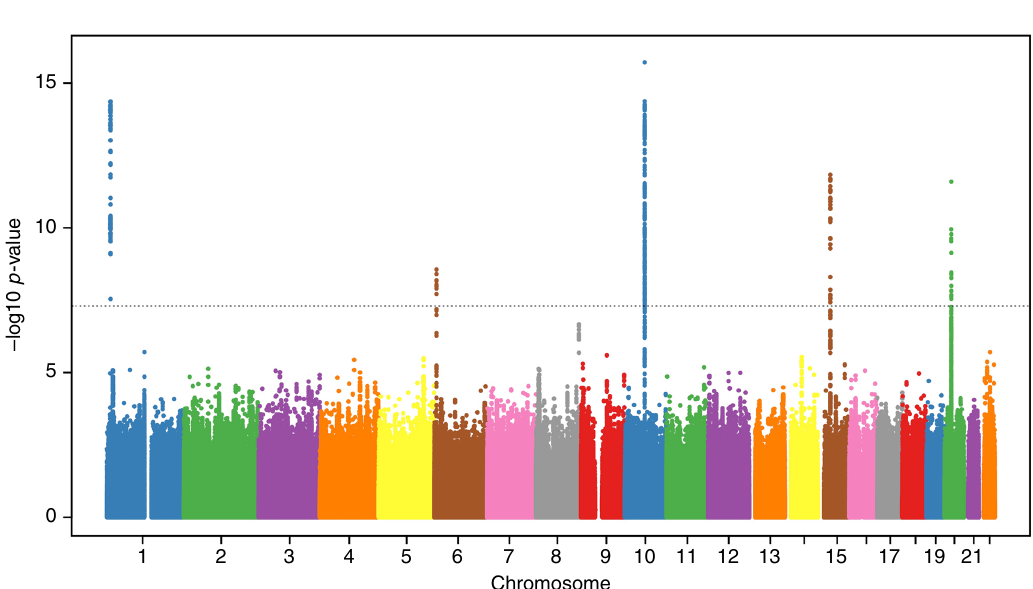
Fig. 1 Manhattan plot of meta-analysis – log 10 P -values for the association of each SNP with EWS risk. Association -log10 p -values for each tested genetic variant are plotted. Chromosomes are plotted sequentially across the x-axis with the scale proportional to chromosomal size. Colors are used to visualize differences in chromosome. The dotted line indicates genome-wide signi fi cance ( P <5×10 -8